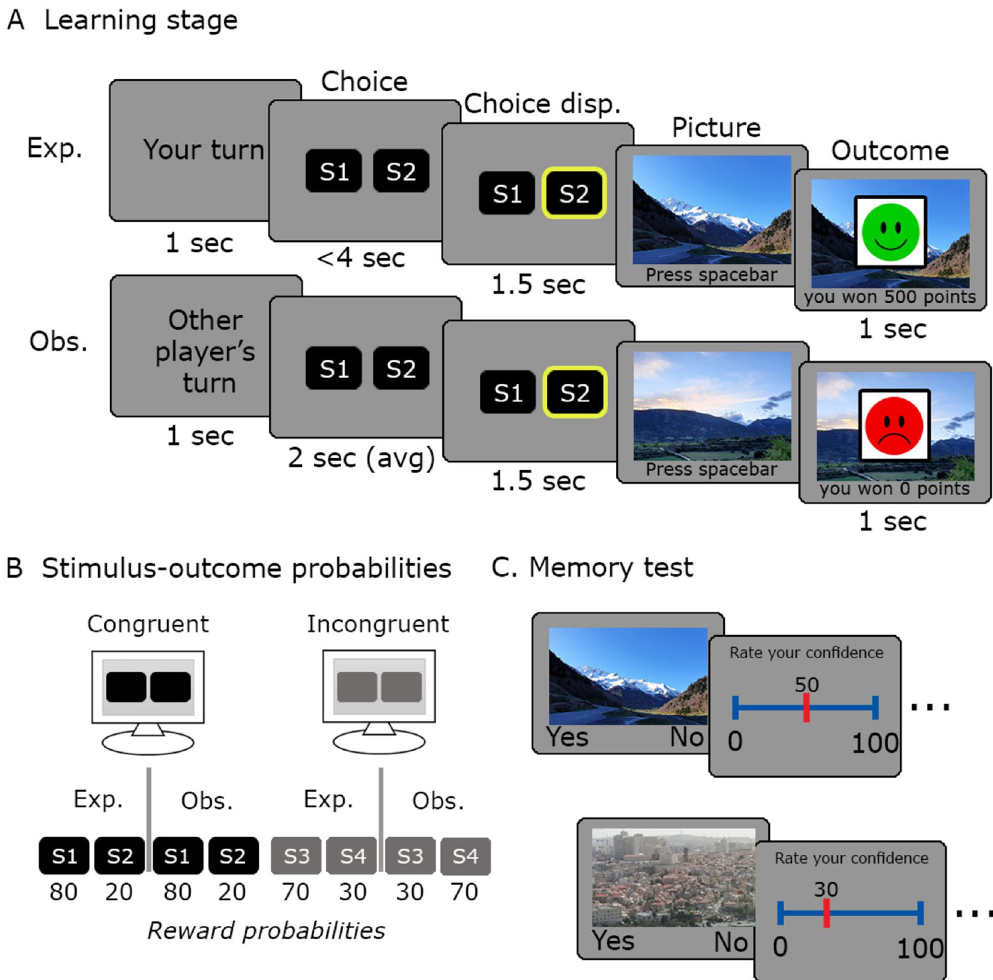
Figure 1. Experimental design. ( A ). The decision-making task included ‘experienced’ trials, in which participants actively chose between two visual cues, each associated with a predefined reward probability; and ‘observed’ trials, in which participants observed the choices of what they were told was a second player (and was actually a computerized simulation). Before revealing a reward or neutral outcome for each choice, a trial-unique picture, unrelated to the reward learning task, was presented in center of screen. ( B ). Two types of stimulus pairs were used in the task: in the ‘Congruent pair’, the cue-outcome contingencies were similar for experienced and observed trials (80:20 reward contingency), and in the ‘Incongruent pair’ trials, cue-outcome contingencies were reversed (70:30 vs. 30:70 reward contingency). ( C ). A surprise recognition memory test was administered immediately after the decision-making task. For each image presented on screen, participants were required to determine whether it appeared during the decision-making part of the task or not, and to indicate their confidence in their decision. S stimulus, Exp. experienced, Obs. observed, disp.